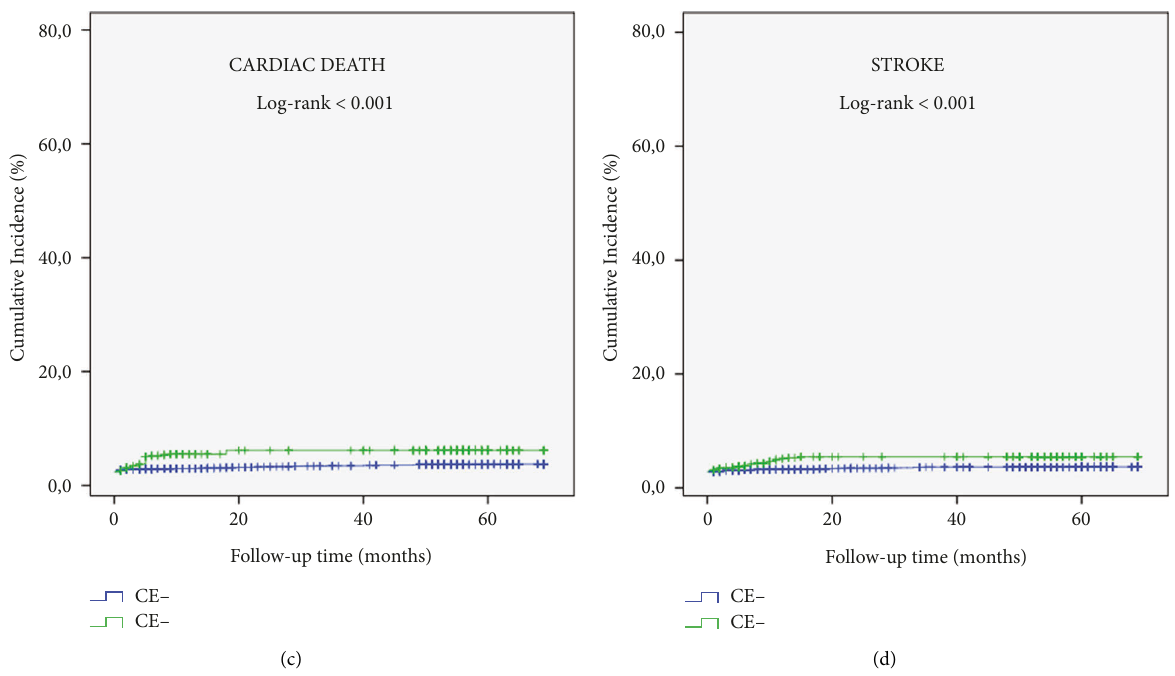
Figure 5: Kaplan–Meier survival curves of cumulative incidence of (a) MACE, (b) myocardial infarction, (c) cardiac death, and (d) stroke in patients with CAE (green line) versus patients without CAE (blue line); MACE, major adverse cardiovascular event; CAE, coronary artery